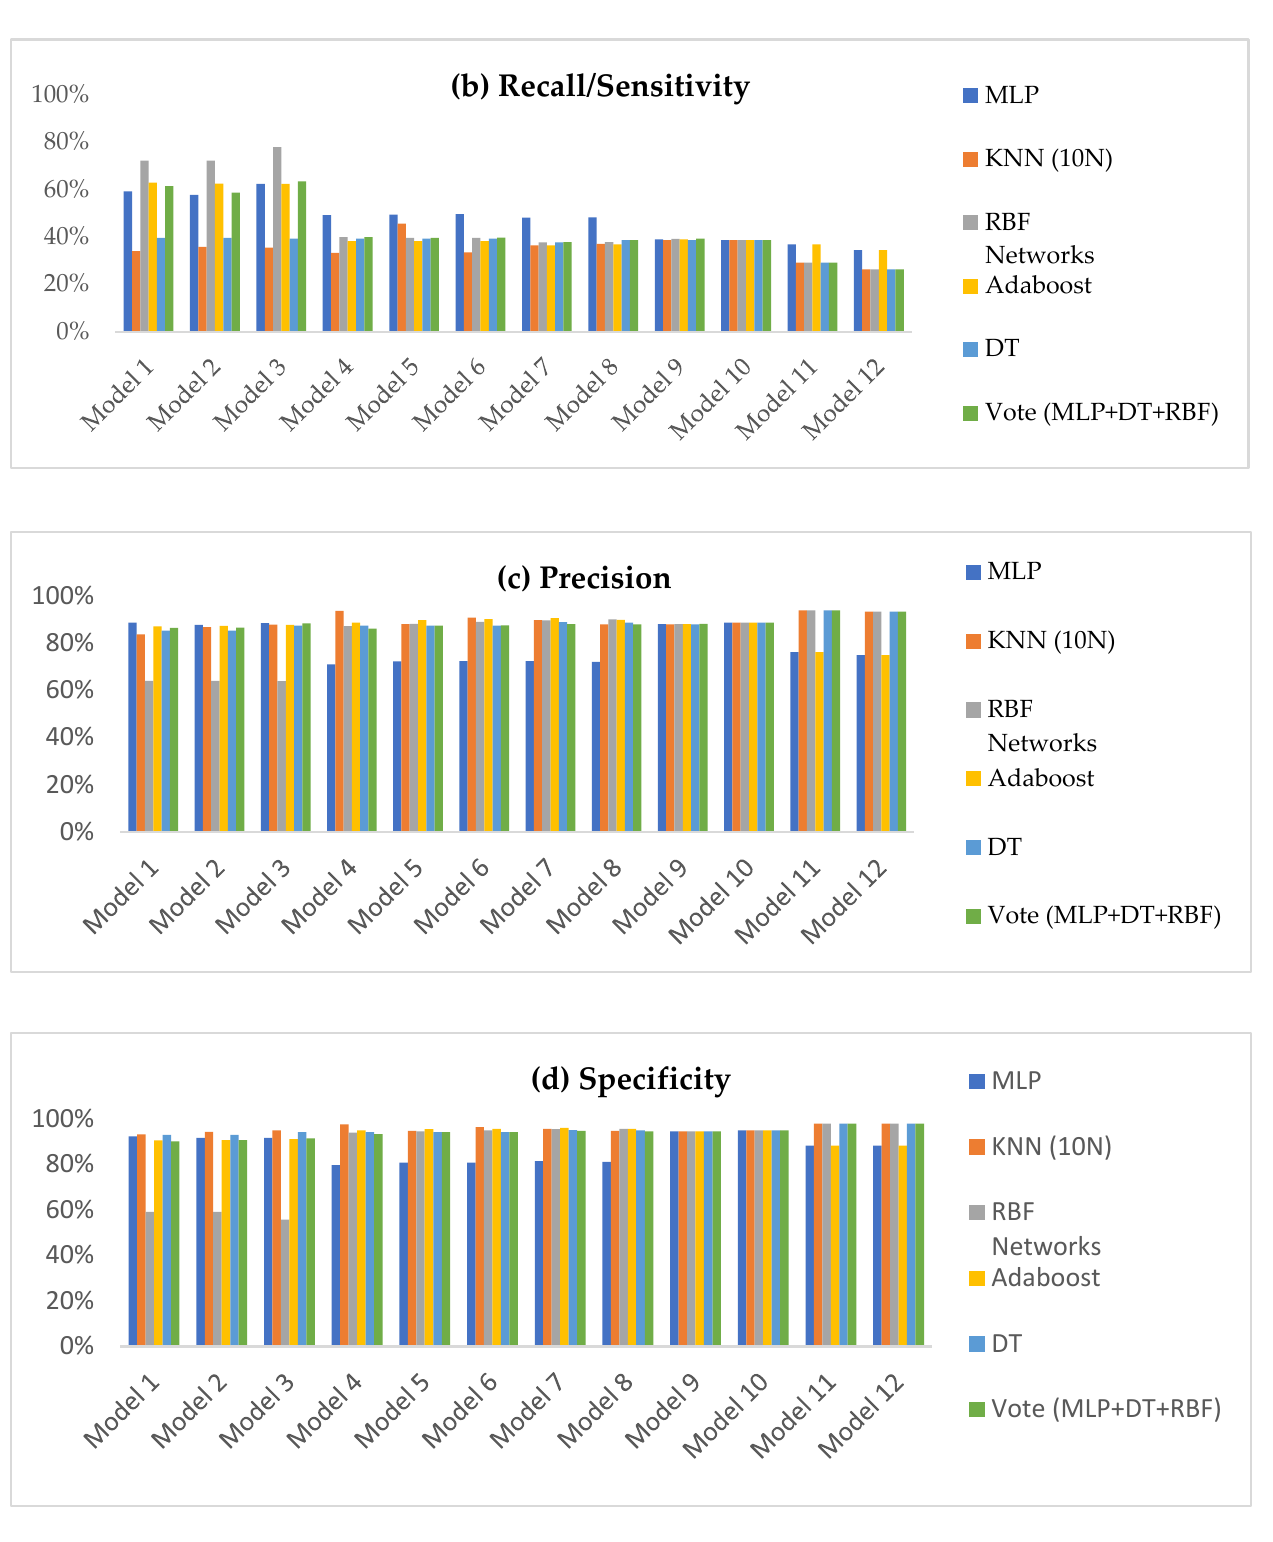
Figure 1. Summary of the performance metrics for six classifiers: ( a ) Accuracy; ( b ) Recall/Sensitivity; ( c ) Precision and ( d ) Specificity.